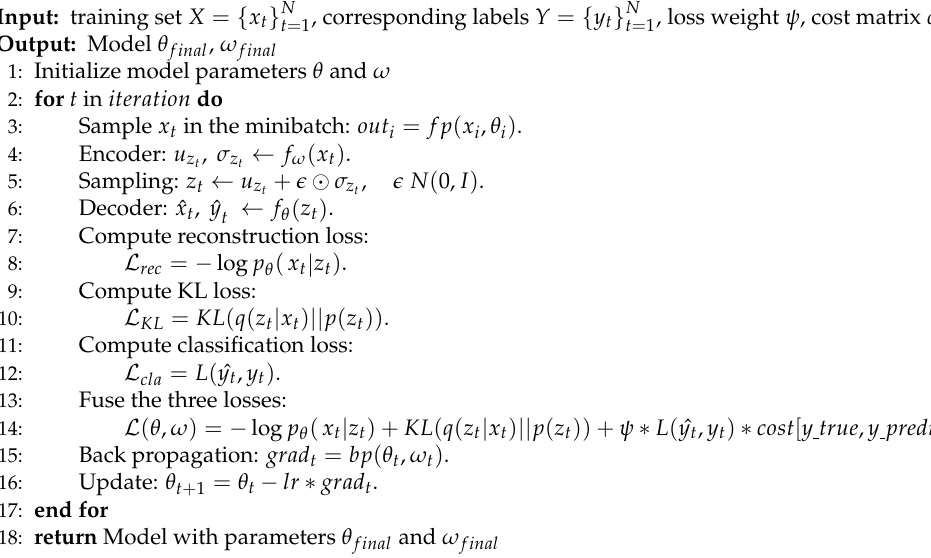
Algorithm 1 Cost-sensitive Variational Autoencoding